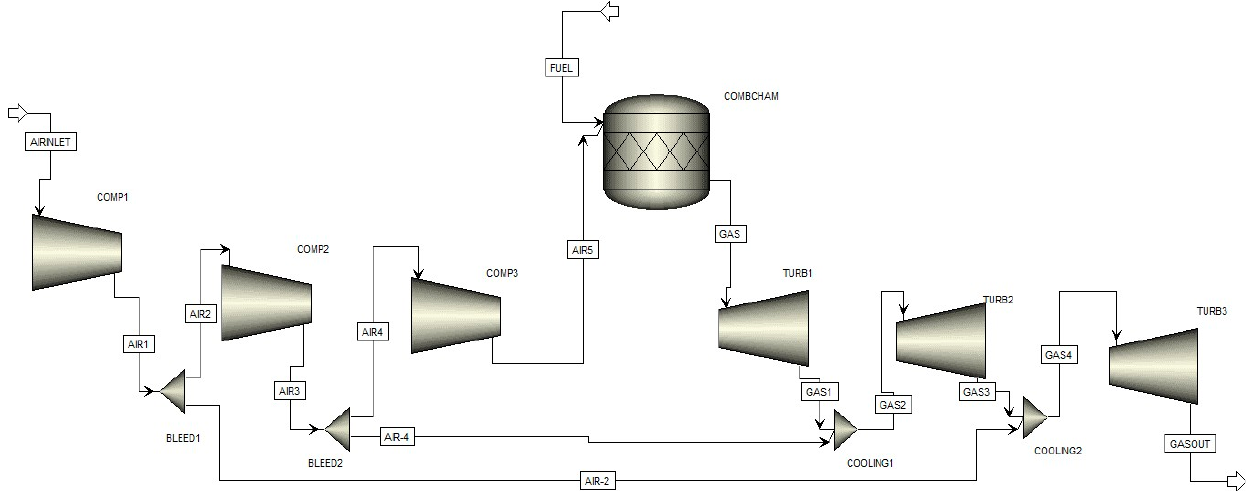
Figure 2. The cooled GTU scheme. Table 1. Initial data for modeling ORC and CCGT on methane–hydrogen blend. Parameter